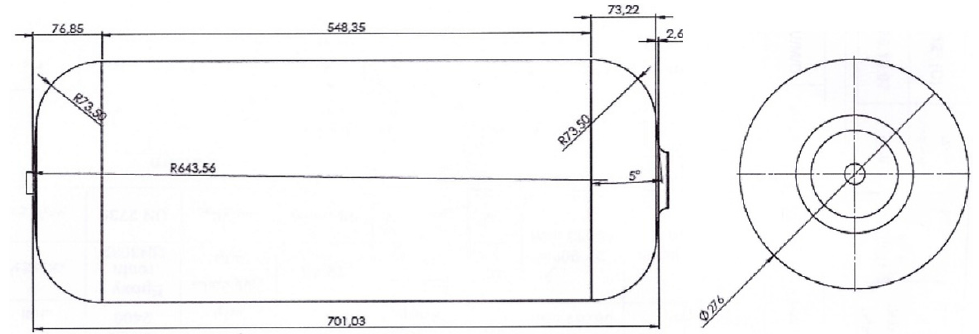
Figure 2. Schematic of the CNG tank with all dimensions in mm [5].